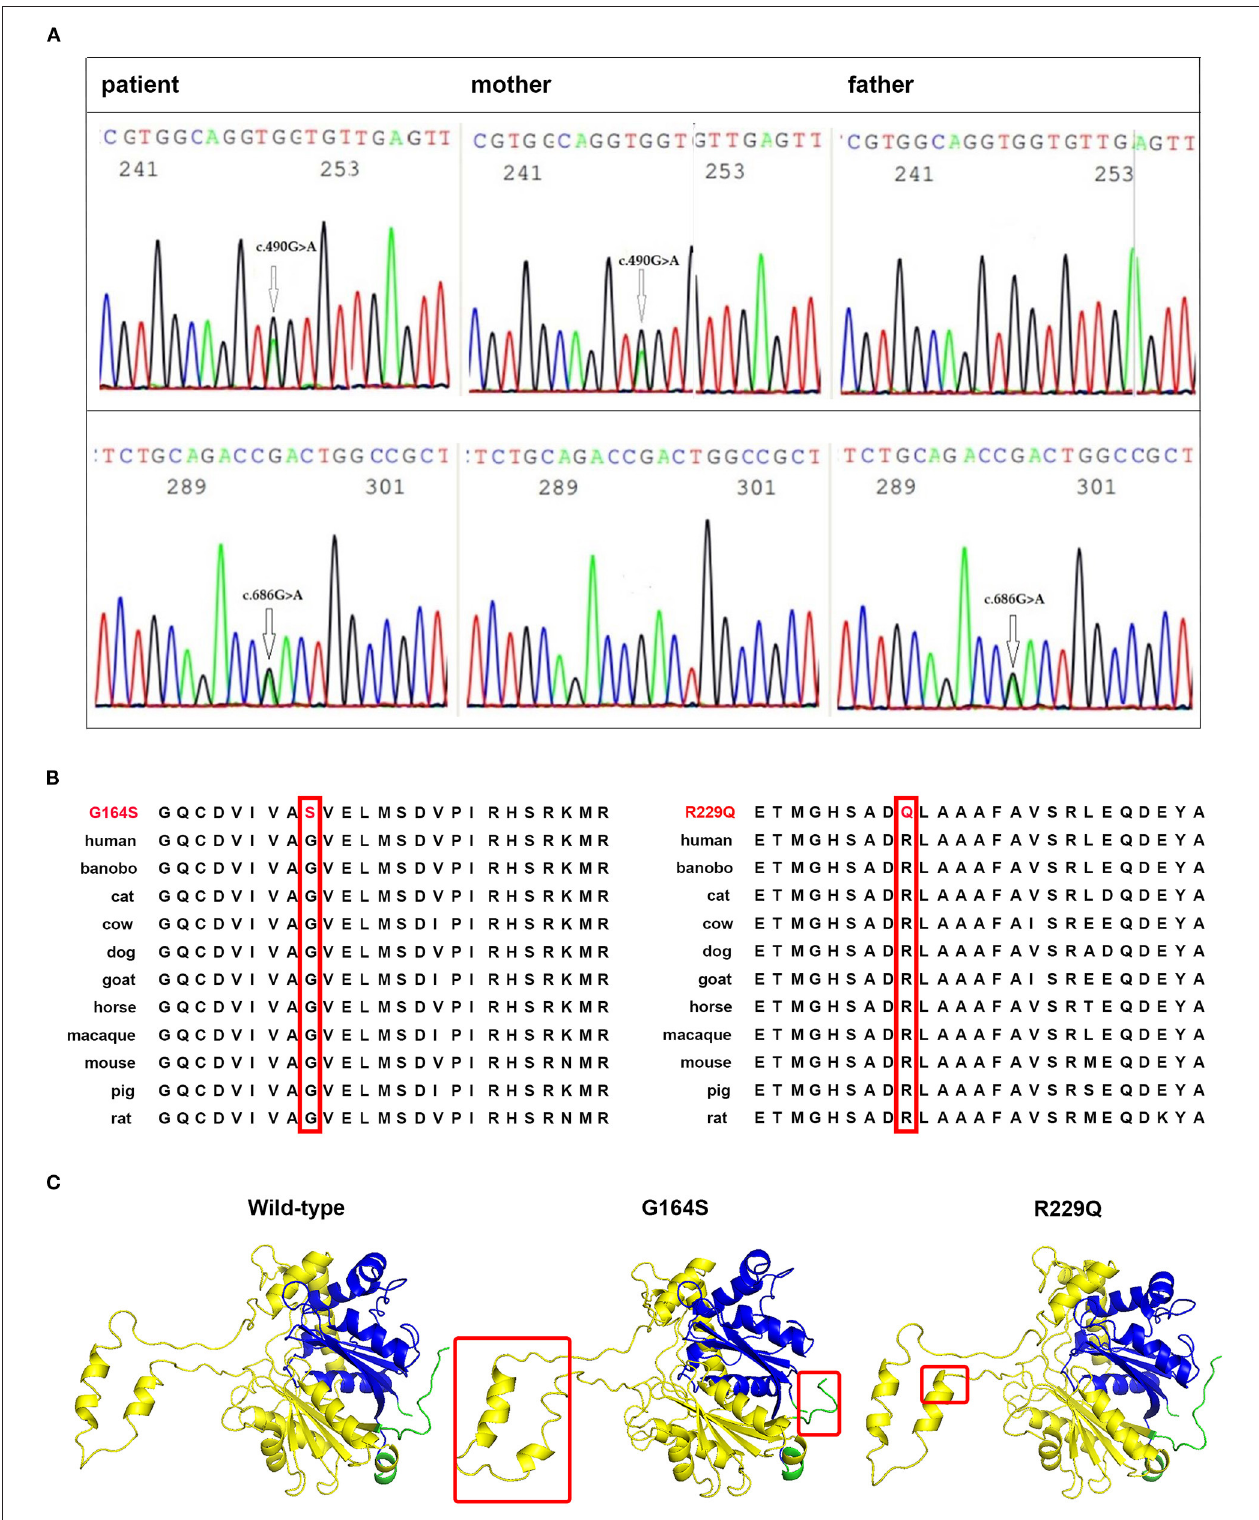
FIGURE 2 | Identification of disease-associated HADHB mutations. (A) Sanger sequencing showing the compound heterozygous mutations, c.490G > A and c.686G > A, in the HADHB gene of the patient and heterozygous mutation in her parents. (B) The glycine residue at codon 164 and arginine residue at codon 229 of HADHB protein are highly conserved among different species (shown in red boxes). (C) Comparison of spatial structure of the wild and mutant HADHB proteins as indicated. The HADHB protein has two domains where the gene encodes thiolase enzyme, N-terminal domain (yellow chain), and C-terminal domain (blue chain). Modified points are marked with a red